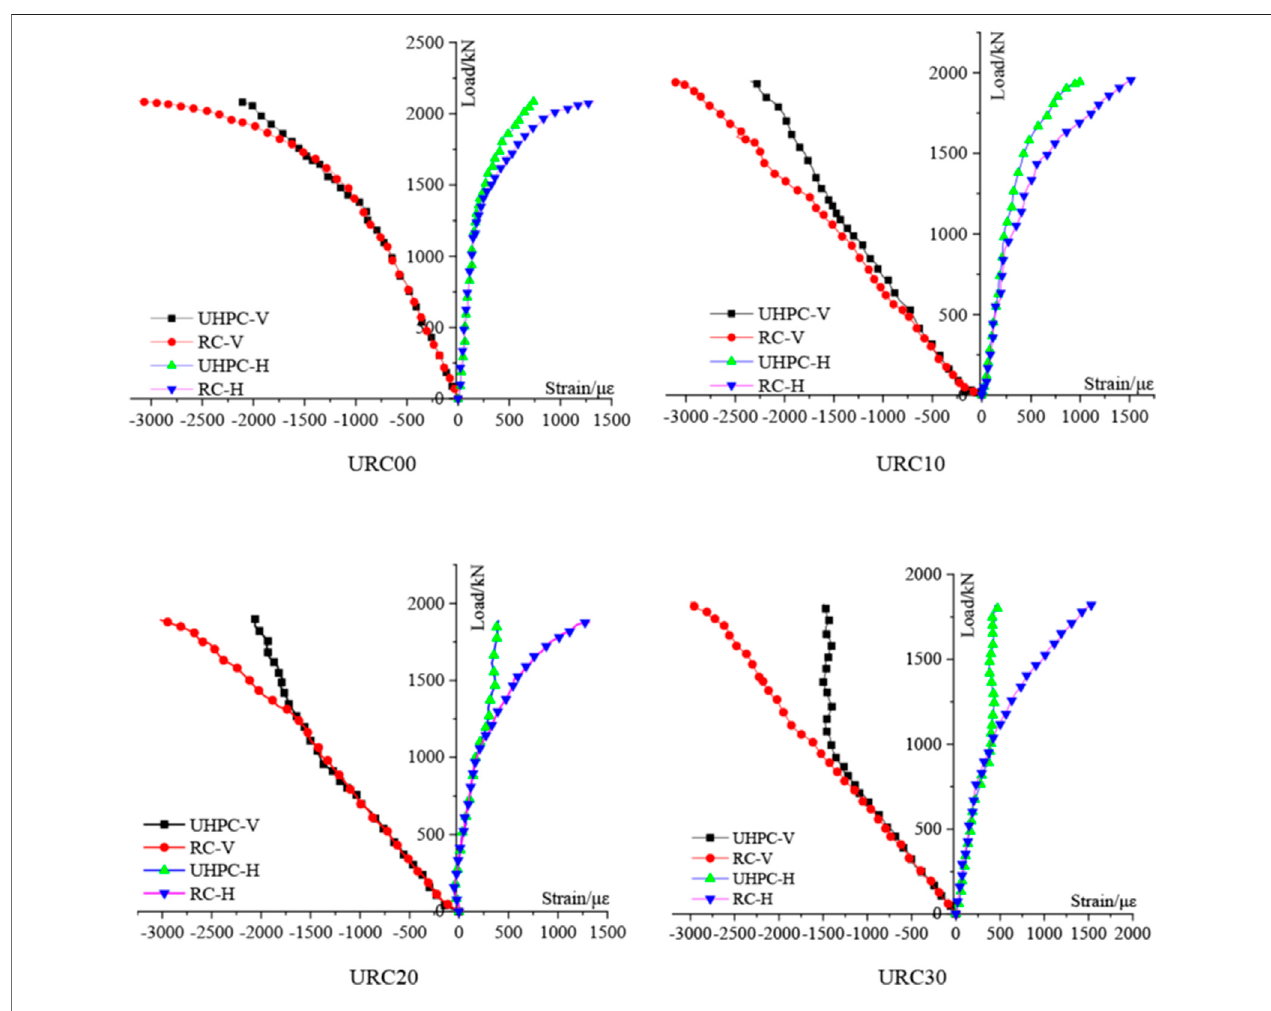
FIGURE 10 | Load-strain curve of reinforced column.